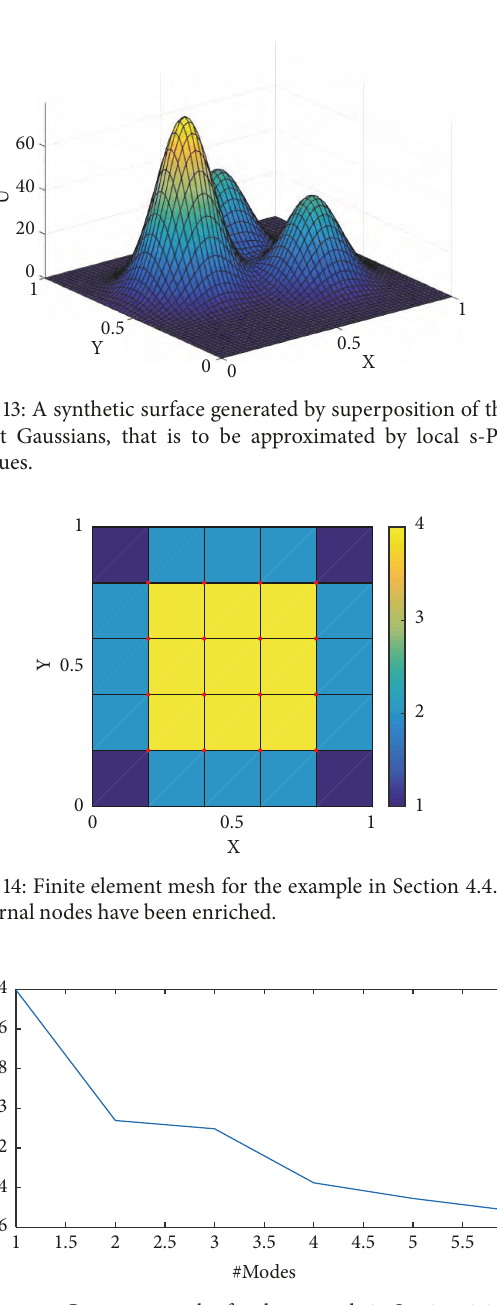
Figure 15: Convergence plot for the example in Section